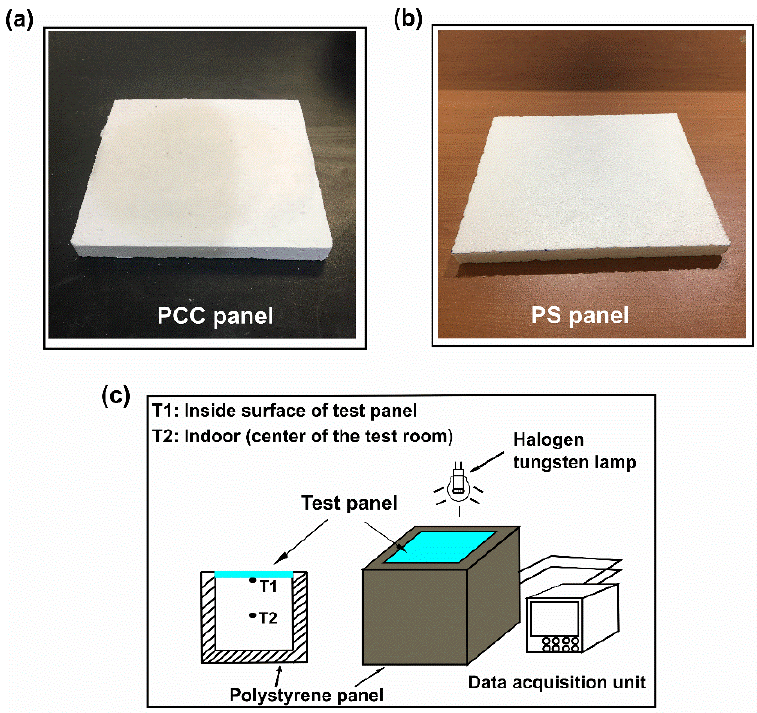
Figure 1. Optical images of ( a ) phase-change composite (PCC) panel, and ( b ) polystyrene (PS) panel, and ( c ) schematic diagram of the experimental setup for examining the temperature variations in a test room.